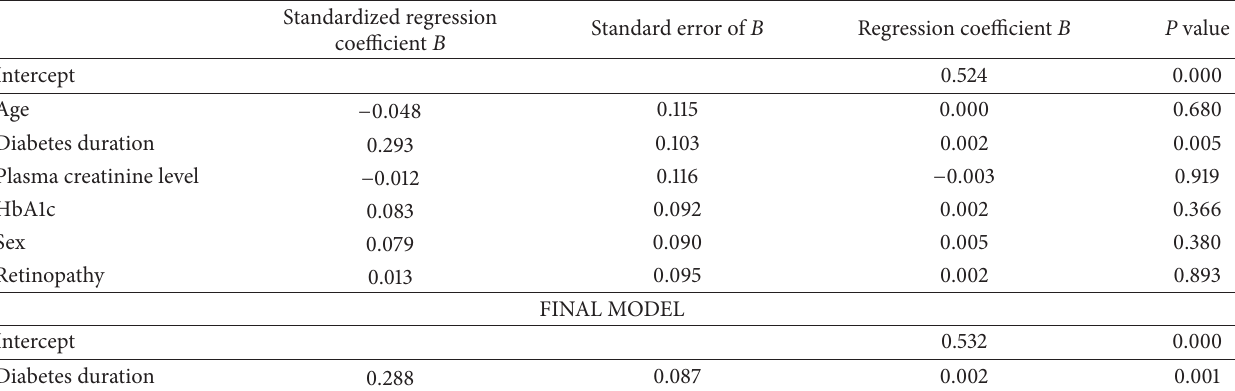
Table 3: Multiple regression analysis for